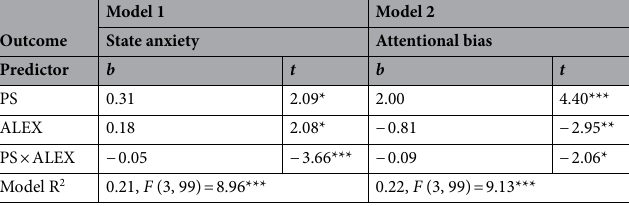
Table 3. Moderation models. PS pandemic-related stress, ALEX alexithymia. * p < 0.05 ** p < 0.01 *** p < 0.001.